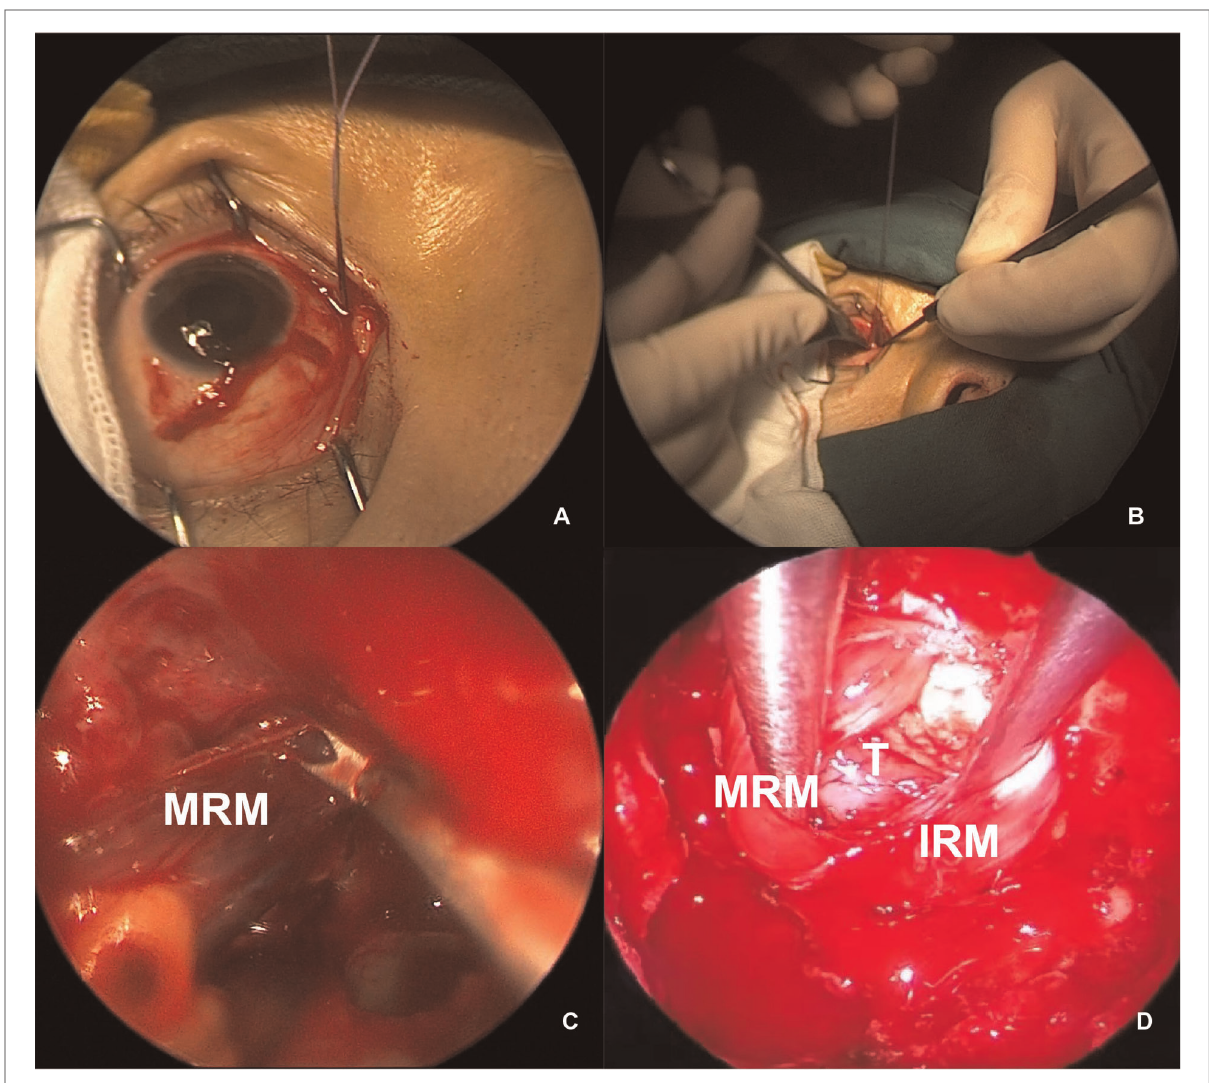
FIGURE 5 Intraoperative view of MRM retraction. ( A,B ) External view of the right MRM identi fi ed and detached, with a stitch looped for control. ( C ) Endoscopic view of the MRM pushed toward the sphenoid sinus. ( D ) The MRM and IRM were retracted transeptally by a second surgeon. MRM, medial rectus muscle; IRM, inferior rectus muscle; T,